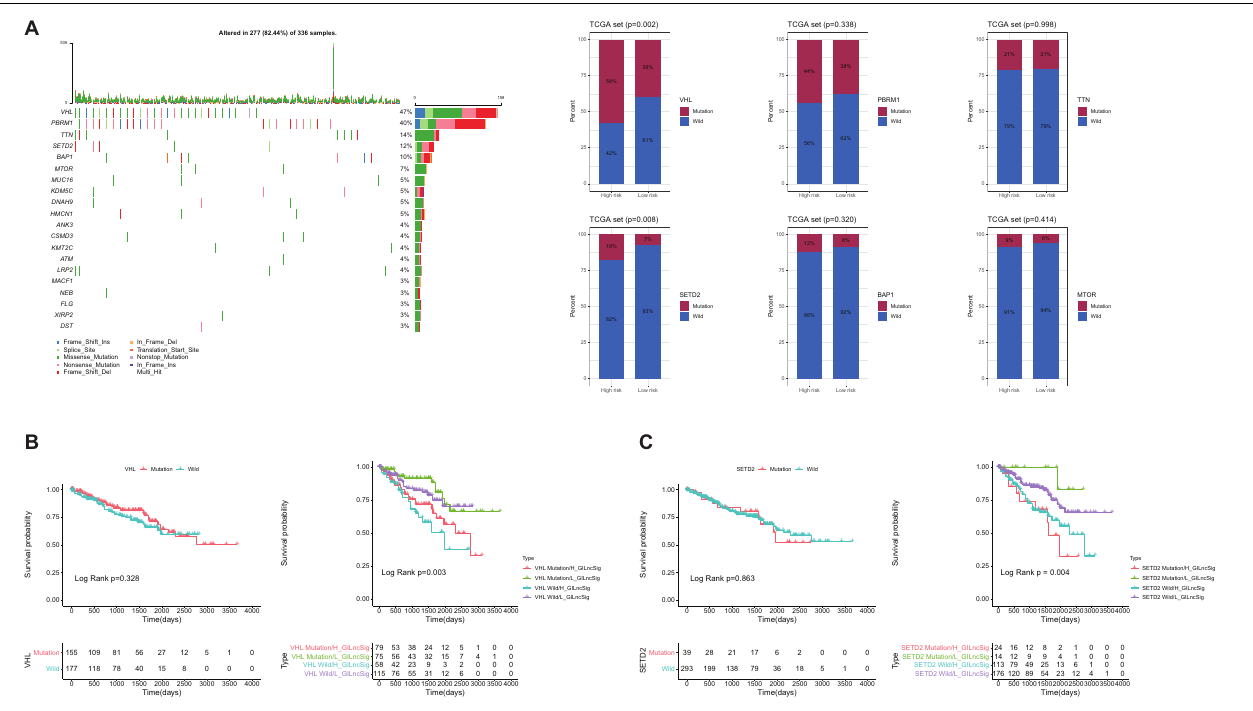
FIGURE 6 | Identification of the mutation characteristics and overall survival in different mutation types. (A) Waterfall plot of the top 20 most frequently mutated genes in ccRCC samples and barplots of the top 20 most frequently mutated genes in the whole TCGA ccRCC sample. Only the proportion of patients with VHL and SETD2 mutations in the High-Risk group was significantly higher than that in the Low-Risk group among the TCGA set. (B) Kaplan–Meier curves of patients with different combination of GILncSig and VHL mutation. (C) Kaplan-Maier curves of patients with different combination of GILncSig and SETD2 mutation.